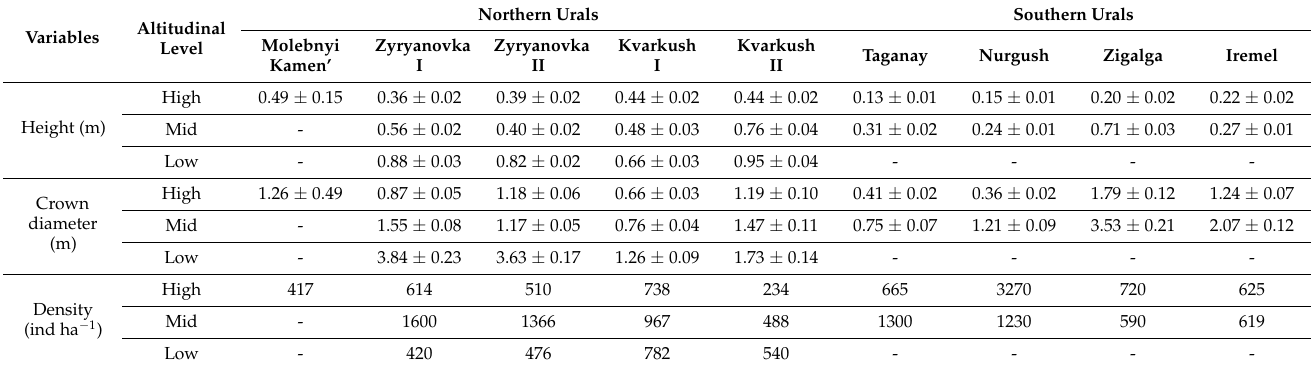
Table 2. Structure data of J. sibirica sampled in the two study regions. Values are means ± SD.